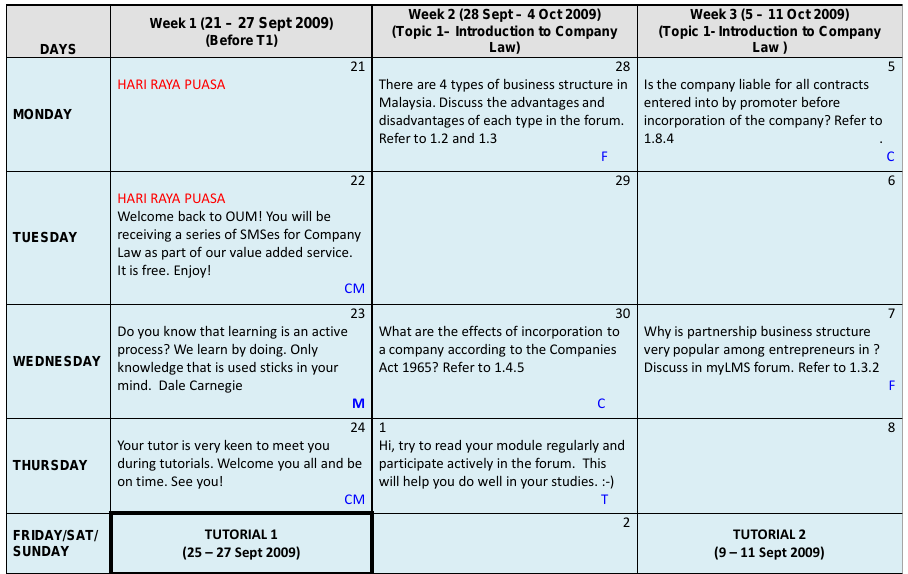
Figure 4. Sample SMS Content and Schedule.